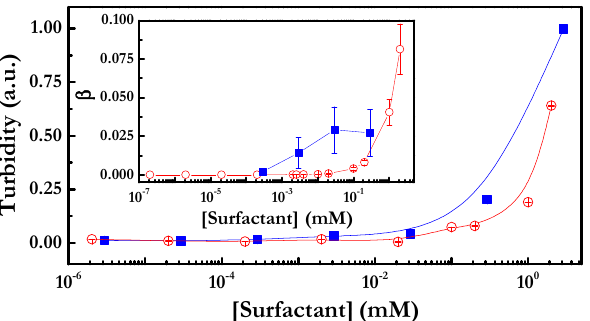
Figure 2. Surfactant concentration dependences of the turbidity of the poly(diallyldimethylammonium chloride) solution (PDADMAC)–surfactant aqueous solutions as was measured at 400 nm. The inset shows the binding isotherms for PDADMAC–surfactant aqueous solutions as were obtained by potentiometric titration. In both panels: PDADMAC-sodium N -lauroyl N -methyl taurate (SLMT) ( ■ ) and PDADMAC-sodium laureth sulfate (SLES) ( ○ ). Lines are intended to act as a guide.